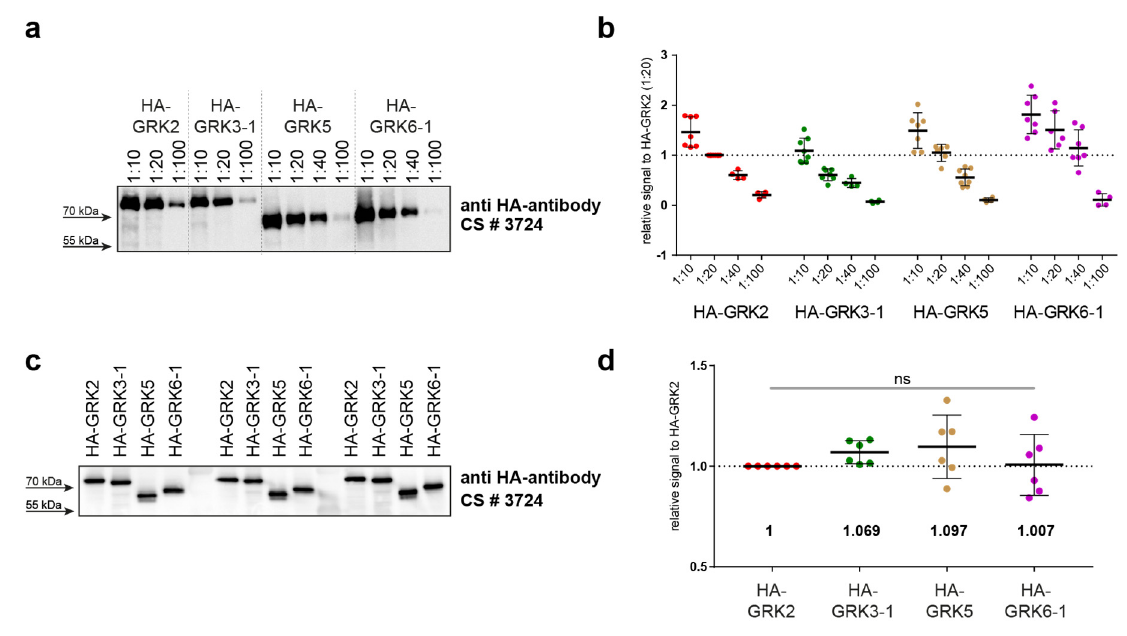
Figure 4. Implementation of protein standards for STARPA. ( a ) To create the HA-tagged GRK protein standards for STARPA, ∆ Q-GRK cells (HEK293 cells with knockout of GRK2, 3, 5, and 6, described in [24]), were transiently transfected with HA-tagged GRK2, 3-1, 5, or 6-1. Serial dilutions of lysates were analyzed for their GRK levels using anti-HA antibody. A representative blot is shown. ( b ) Blots were quantified, and the relative signal compared to the respective signal in the 1:20 dilution of HA-GRK2 are shown as dot plots with corresponding means ± standard deviation (SD), indicated by bars. ( c ) According to the results shown in ( b ), new dilutions from the same lysates were created with the aim to contain equal protein concentrations of the corresponding HA-GRK isoform. Their HA-GRK level was determined via Western blot analysis using anti-HA antibody. A representative blot showing 3 of 6 datasets is shown. ( d ) Blots were quantified, and the relative signals compared to the respective signals in the HA-GRK2 of each dataset are shown as dot plots with corresponding means ± SD, indicated by bars. Additionally, means are stated below the dot plots. No statistical differences (ns) were found using one-way ANOVA and Tukey’s test.